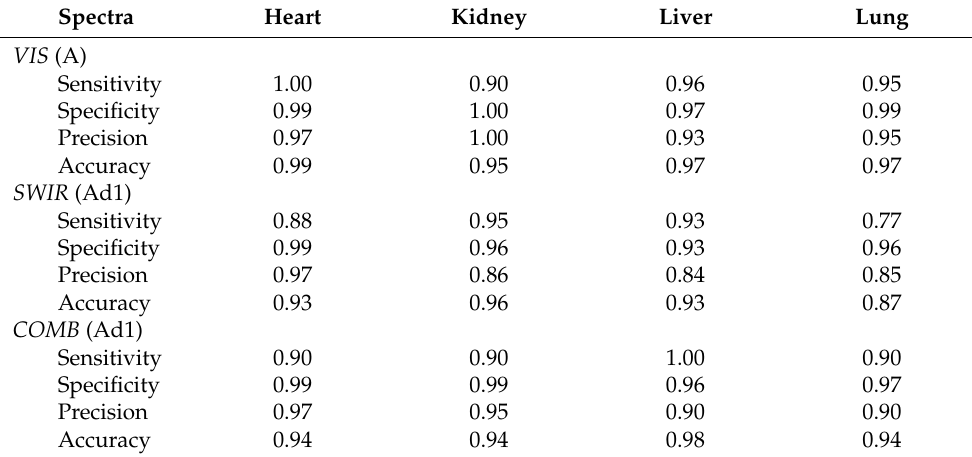
Table 4. Livestock organ classification from hyperspectral sensors using partial least squares discrimi- nant analysis (PLS-DA) for visible (VIS), short-wave infrared (SWIR) and combination VIS and SWIR (COMB) hyperspectral sensors on the in-sample dataset.